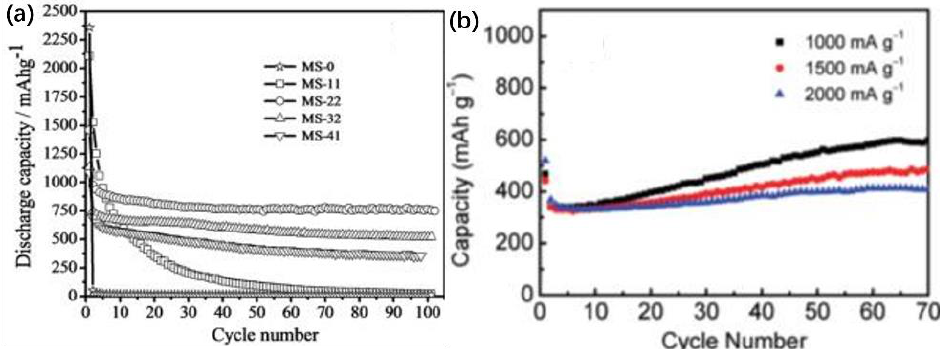
Figure 10. ( a ) Cycling stability of pure MoS 2 and various MoS 2 -carbon composites. ( b ) Cycling performance of the MoO 2 /graphene composite electrodes in the range of 3–0.01 V vs. Li at current densities of 1000, 1500, and 2000 mA/g. Copyright © 2011 American Chemical